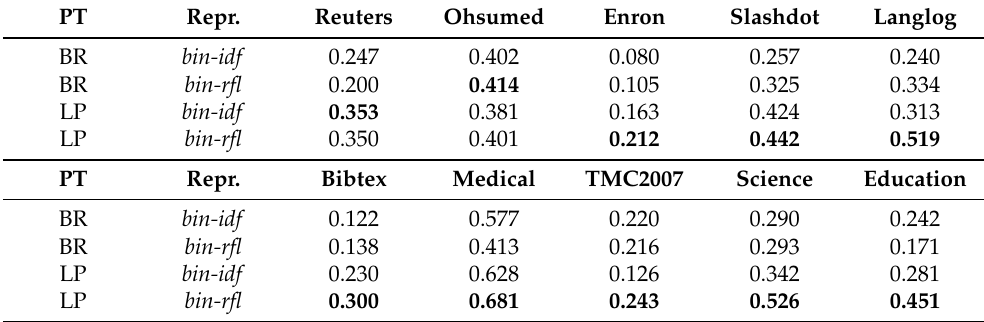
Table 6. Experimental results of different transformations of the problem (PT: BR and LP), and Representations with SVM in terms of